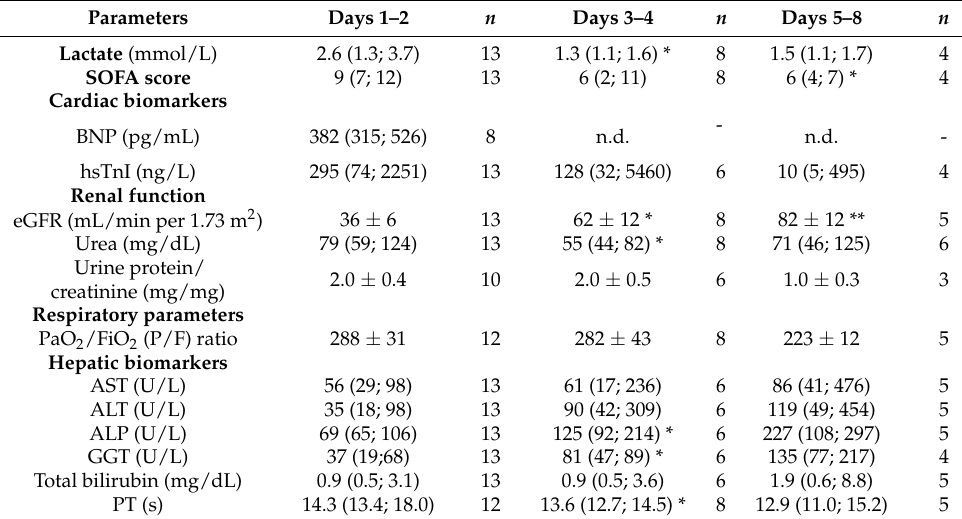
Table 4. Clinical and biochemical parameters of organ dysfunction during hospitalization in SS